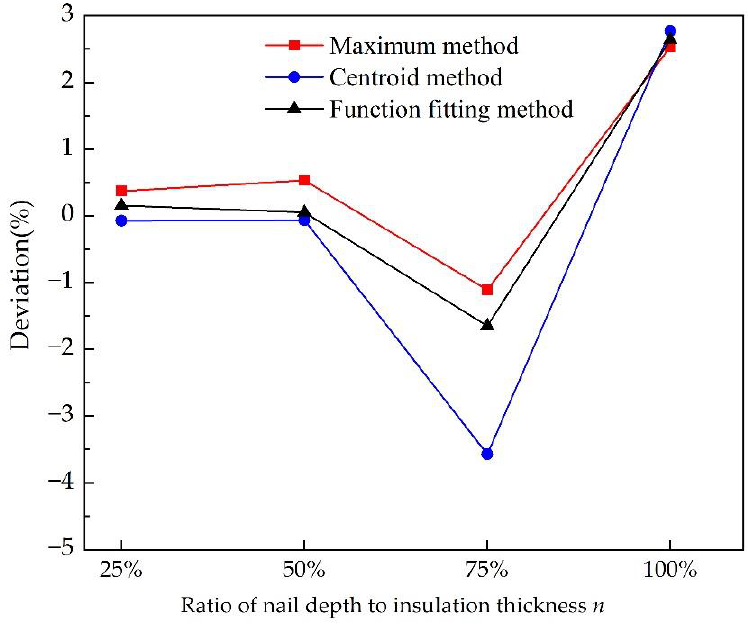
Figure 12. The deviations of nail insertion with three